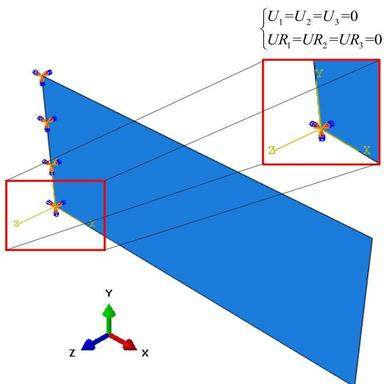
Boundary condition of the cantilever plate.